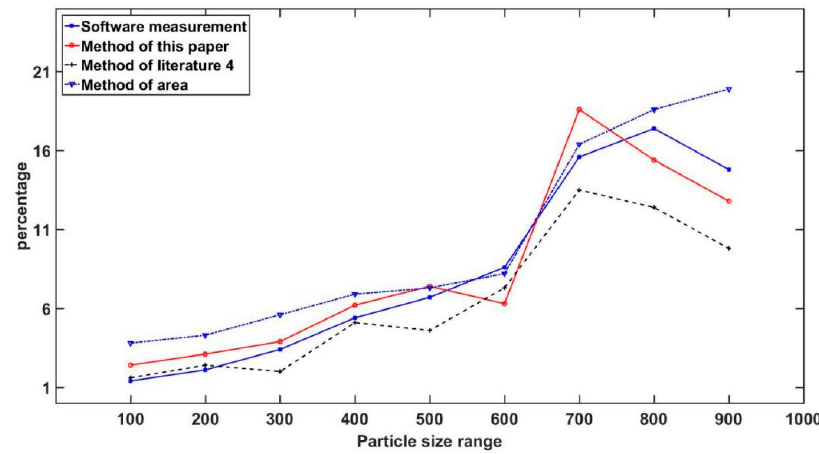
Figure 10. Comparison of wood powder particles.